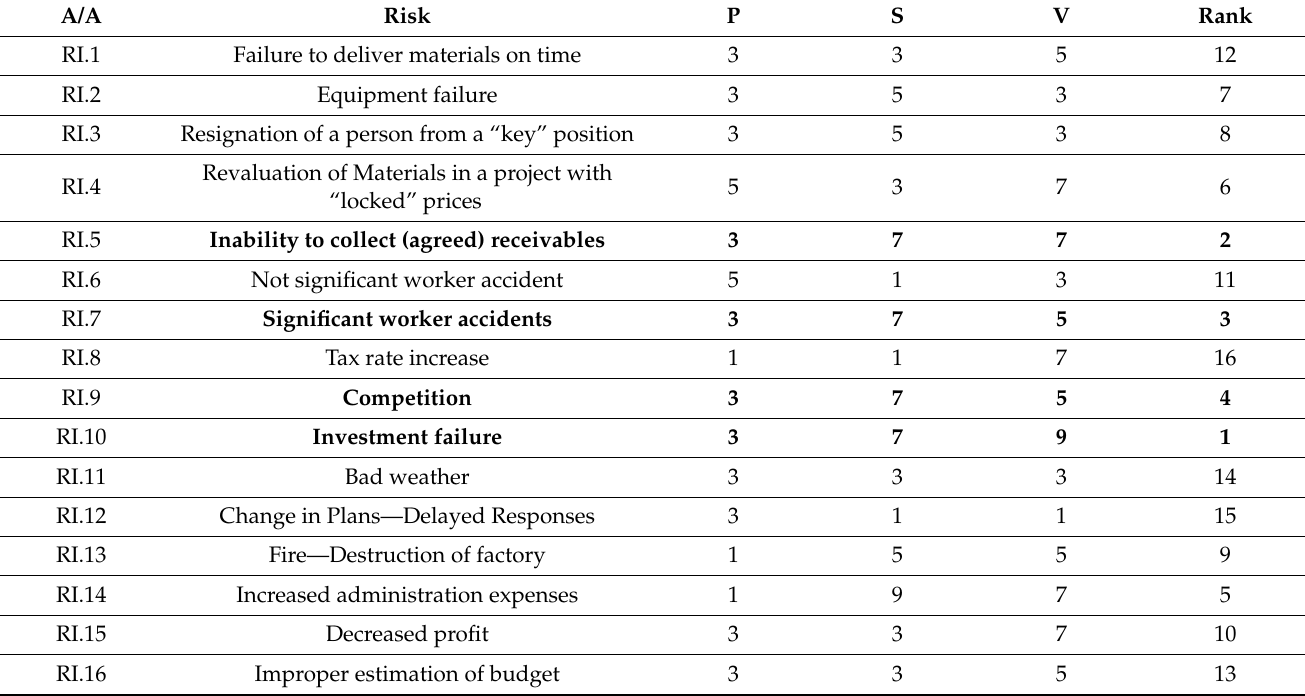
Table 4. Risk—risk register table with values P, S, and